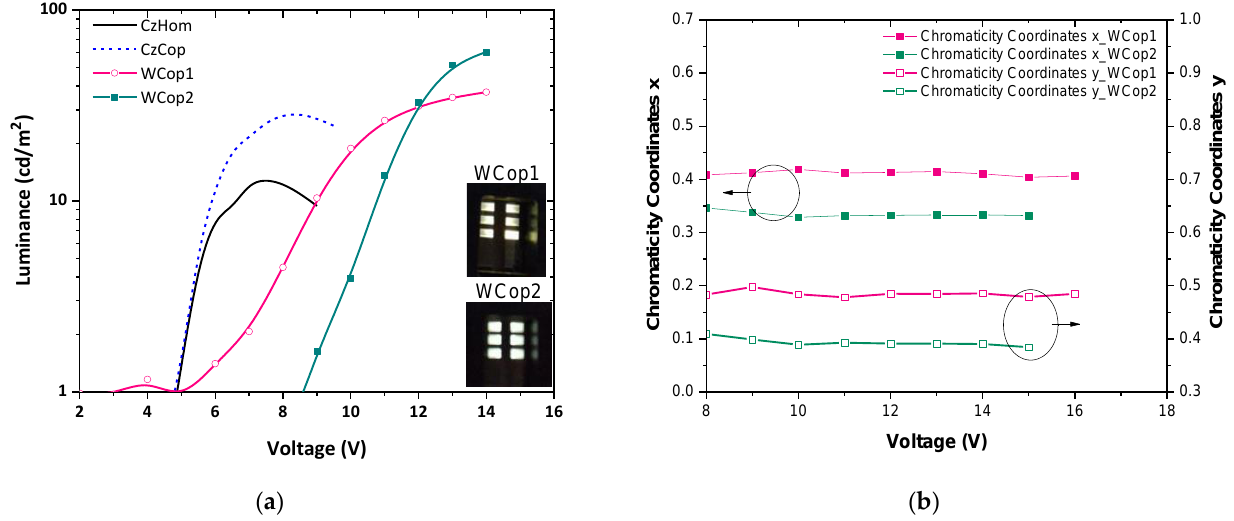
Figure 13. ( a ) Logarithmic plot of Luminance-voltage characteristics. The inset presents the photographs of WCop1 and WCop2 devices operating at 14V. ( b ) The dependence of the CIEx and CIEy coordinates on the Voltage of the fabricated OLEDs. Table 5. The electrical–operational characteristics of fabricated OLED